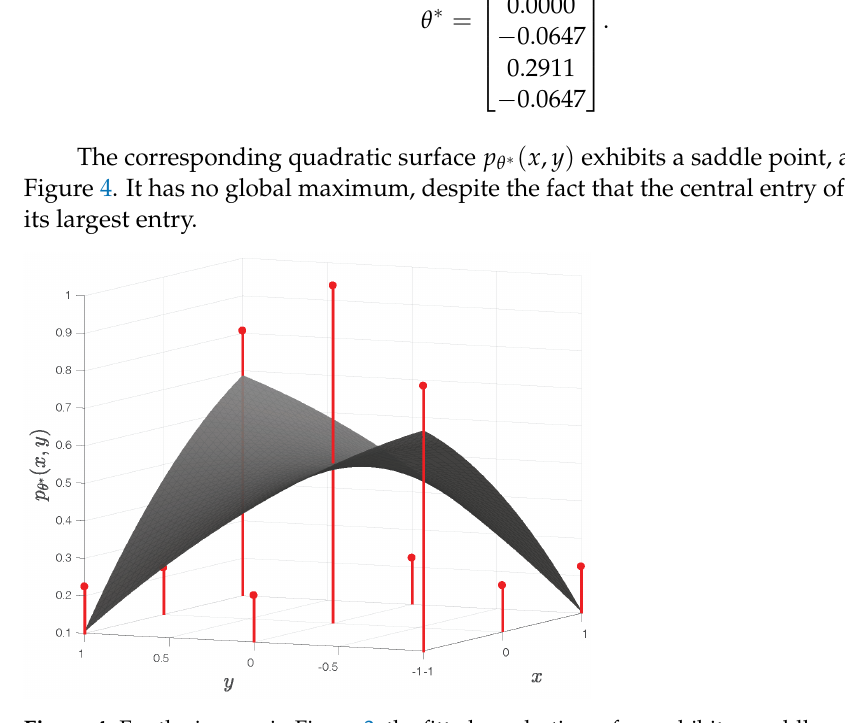
Figure 4. For the images in Figure 3, the fitted quadratic surface exhibits a saddle point. The vertical red line segments represent the entries of the normalized cross-correlation matrix Γ